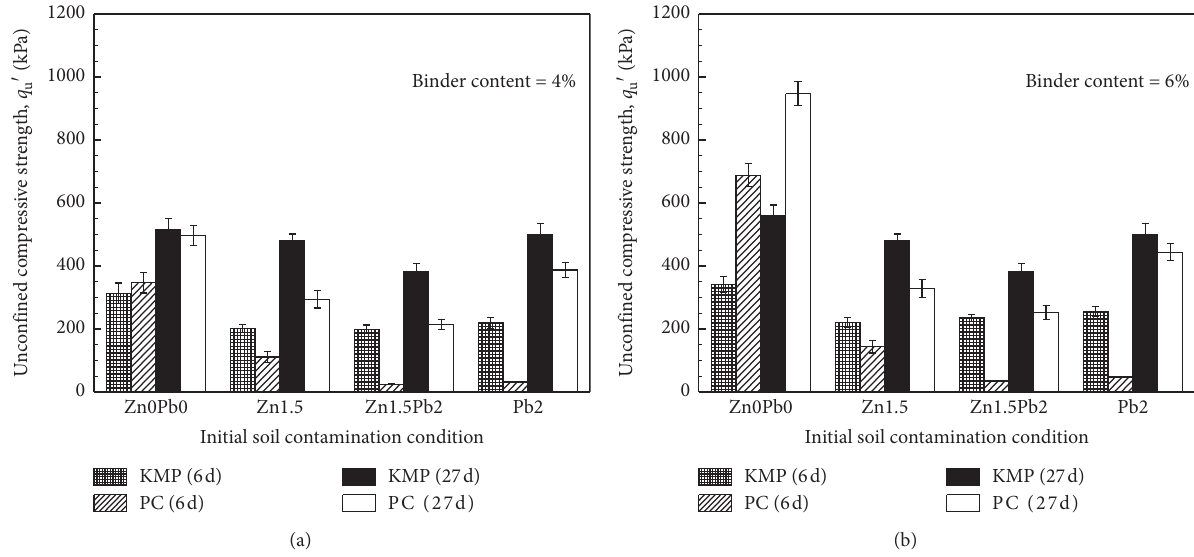
Figure 4: Variations in the unconfined compressive strength ( q u ′ ) with the initial soil contamination conditions for the stabilized soils after water-soaking tests: (a) 4% binder and (b) 6% binder.